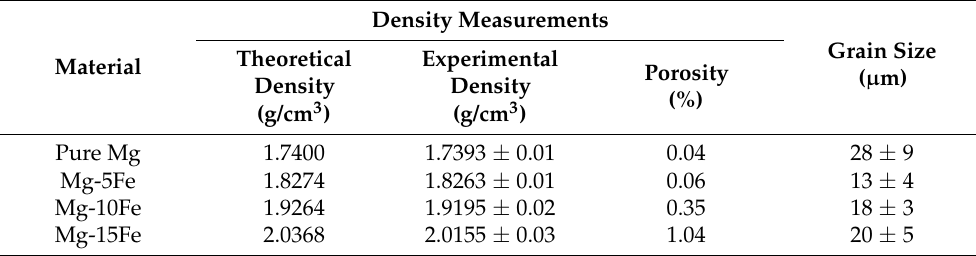
Table 1. Density, porosity, and grain size of pure Mg and Mg-Fe composites.